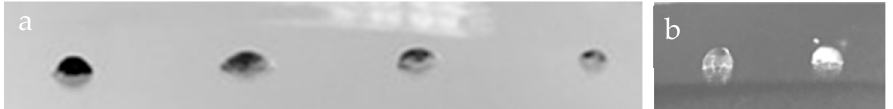
Figure 1. Images of collagen and alginate clusters. Collagen beads were created by two-step polymerization phases at 37 °C for 30 min ( a ). Alginate beads were formed by dropping jelly biomaterial in CaCl 2 solution ( b ).